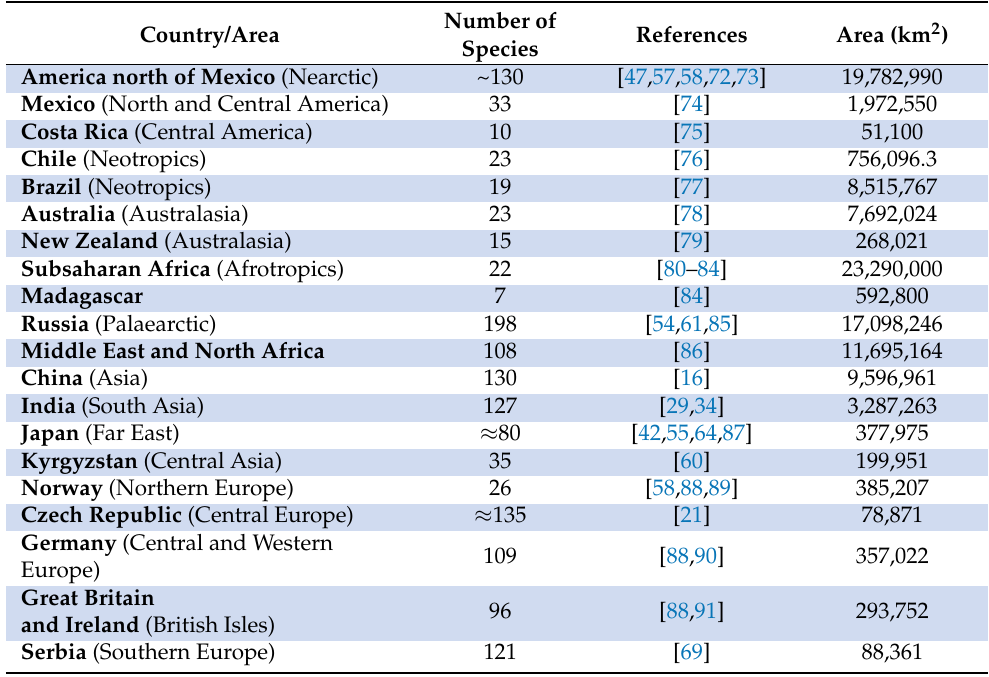
Table 2. Number of Aphidiinae species recorded in some countries/areas, with references in square